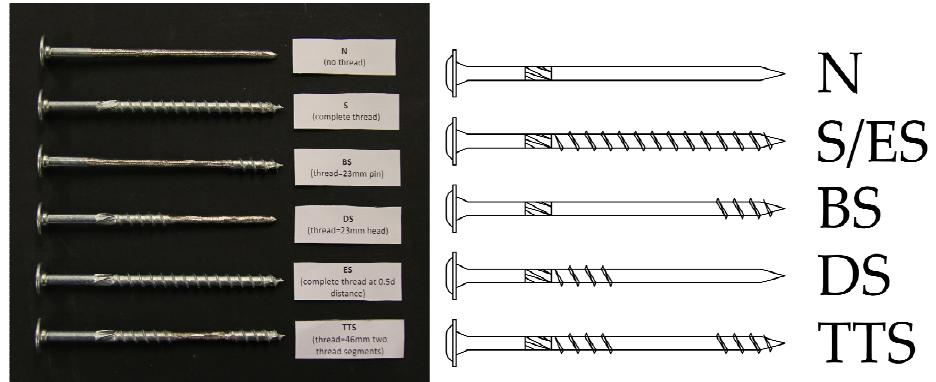
Figure 3. Screws with different thread lengths.